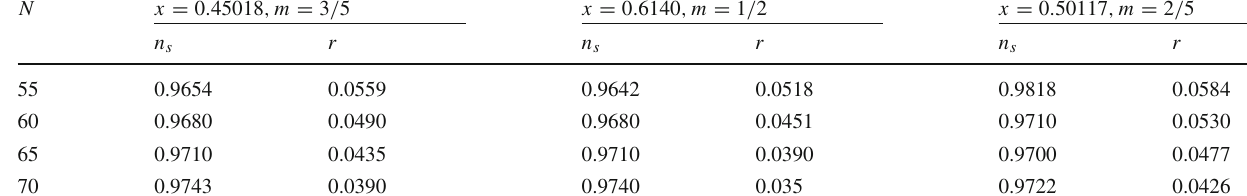
Table 1 For q = − 1 , n = 1, Inflationary observables for the different choices of the potential parameters ( x and m ) with variety of total number of e-fold, all the observables are consistent with the Planck (cid:3) 18 [55]